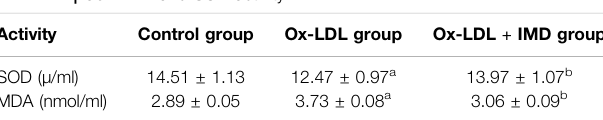
TABLE 2 | Cell MDA and SOD activity.